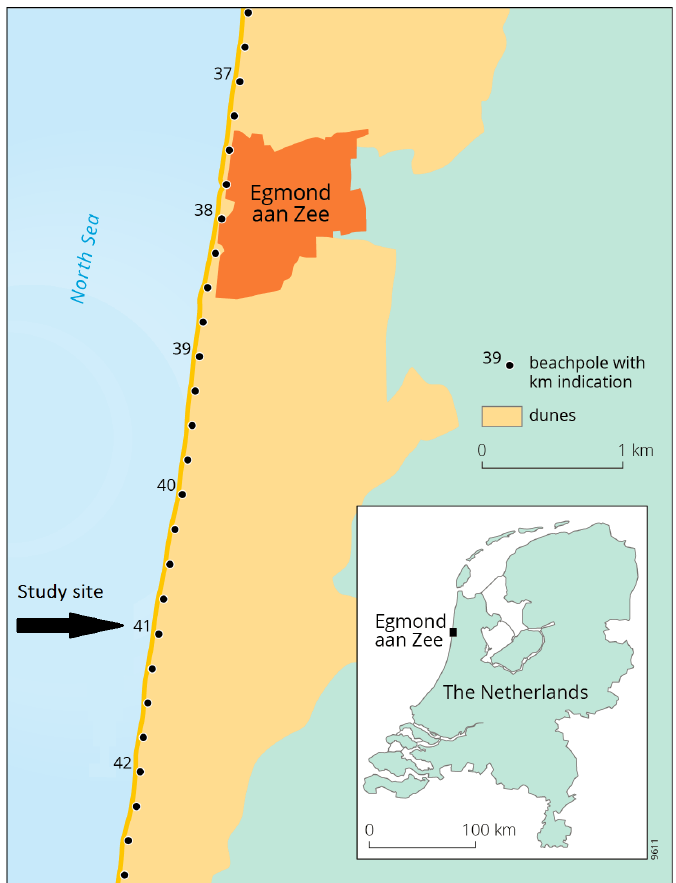
Figure 1. Location of study site. The number of a beach pole is the distance (in km) to the zero point at the northern end of the Dutch Holland